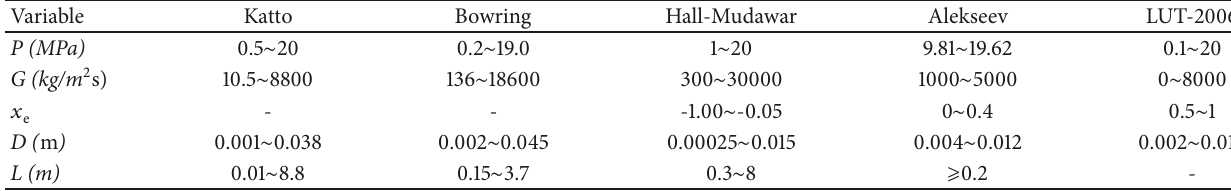
Table 3: Parameter ranges of CHF correlations.